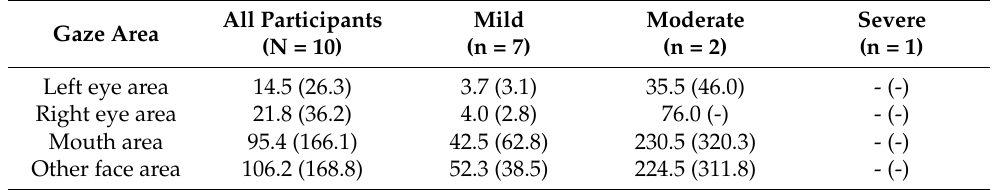
Table 2. The duration of each gaze episode on the face of avatar, mean (SD), seconds. Gaze